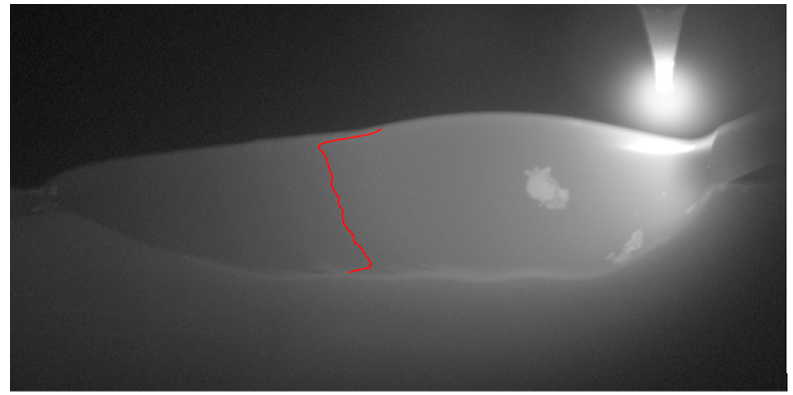
Figure 4. A still frame from the thermal imaging with the phase boundary overlaid in red.